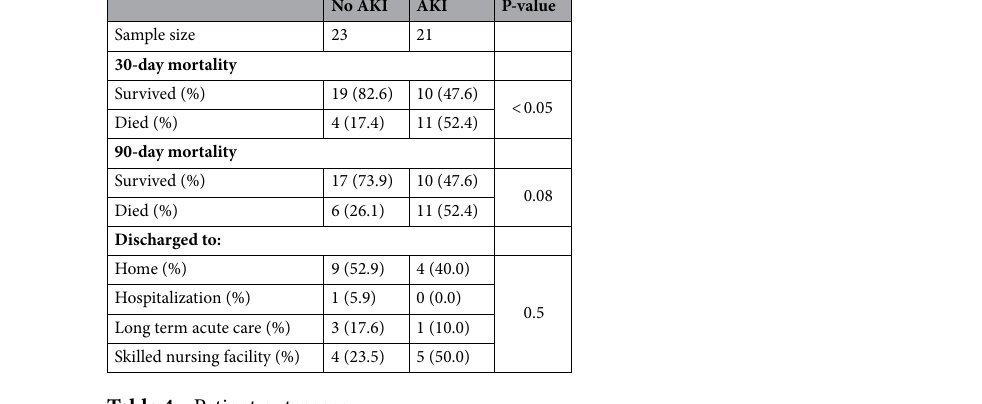
Table 4. Patient